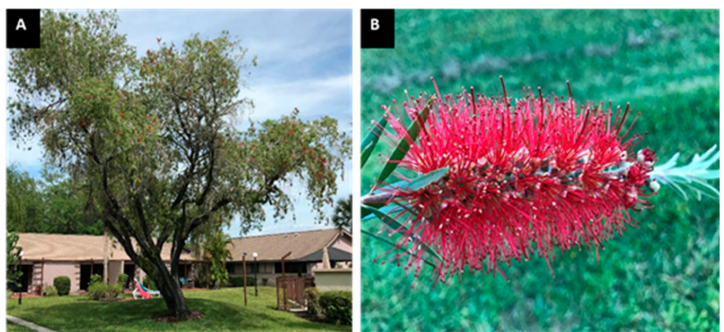
Figure 1. Images of C. lanceolatus whole tree ( A ) and flowers ( B